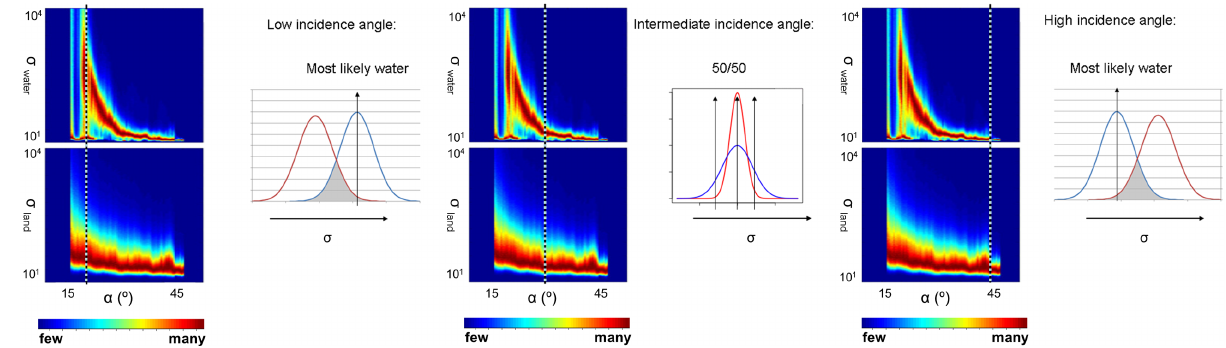
Fig. 3. Explanation of the ability to distinguish between water and land for different incidence